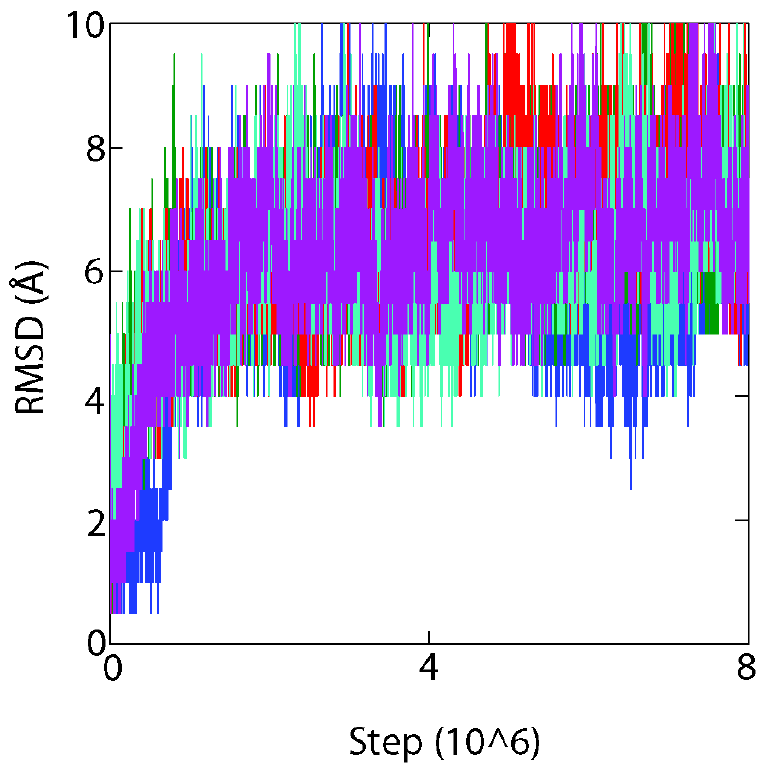
Figure 1. Time evolution of the C a RMSD of the current umbrella center for five representative simulations demonstrating the presence of reversible folding.